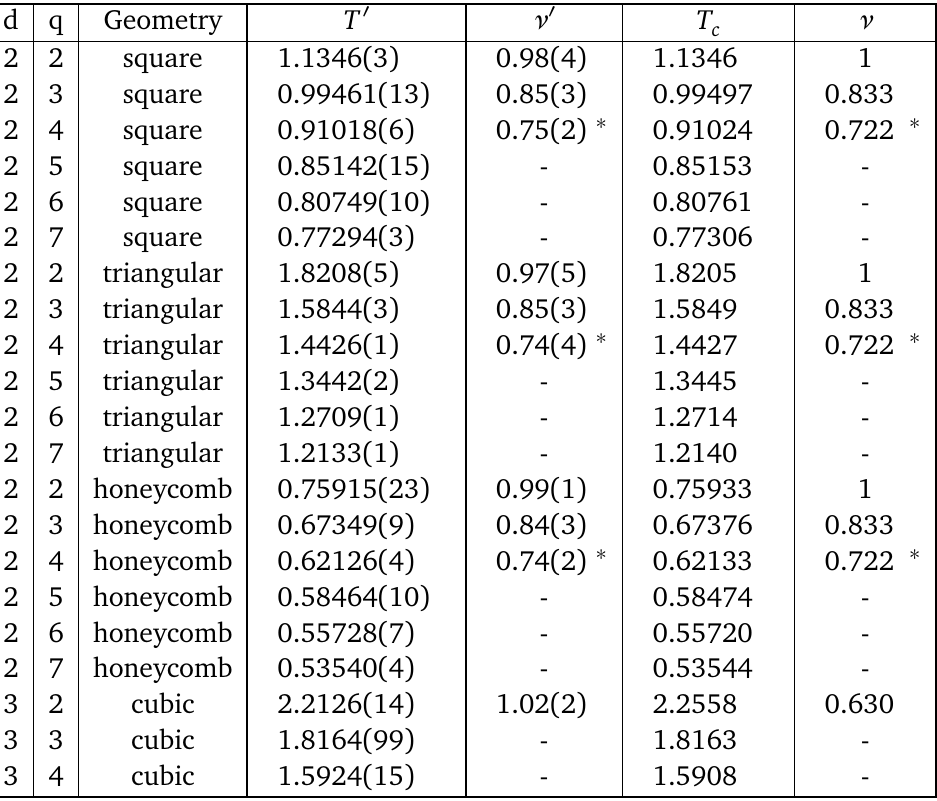
Table 1: Critical properties of the ferromagnetic q -state Potts model obtained using ANNs trained with MC data. The values of T (cid:48) and ν (cid:48) and their associated standard errors are estimated by finite-size scaling of ANN outputs. Literature values of T and ν are included for comparison. ∗ The values of ν (cid:48) and ν [ 15 ] for the 4-state Potts model are without higher-order corrections.